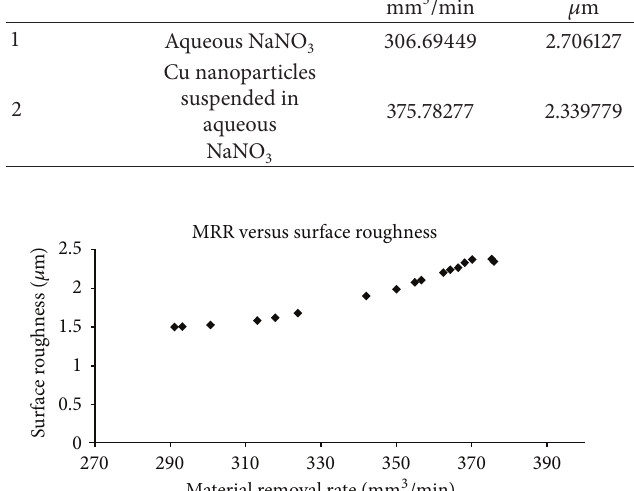
Table 5: Error between optimum values from GA and confirmation test value for maximum MRR. Sl. number